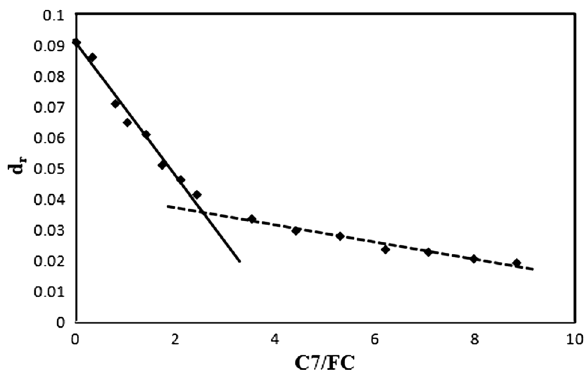
Fig. 21 Reduced density of fluid FC {crude oil C (5 g) + cyclohexane (7.5 g) + n -heptane ( X g )} as a function of the ratio of n -heptane and available crude oil (Ekulu et al.